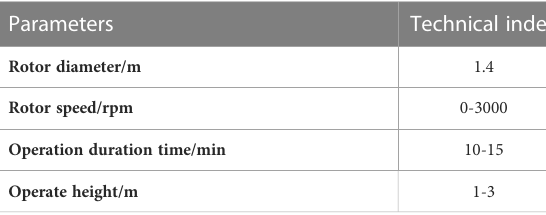
TABLE 2 Power system parameters of plant protection UAV.